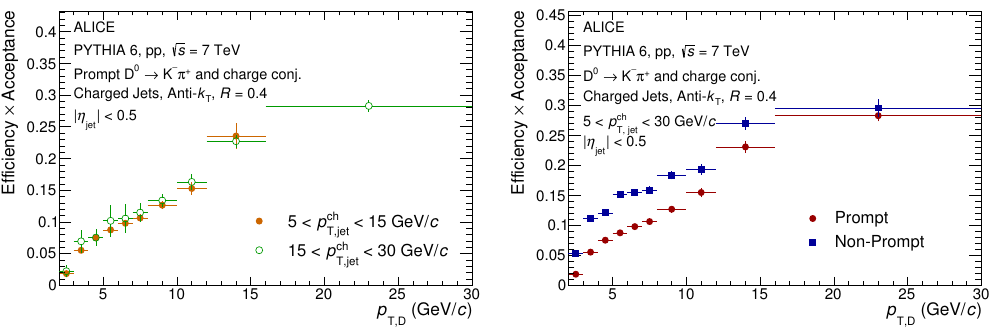
< 15 GeV =c (full circles) and T ; jet